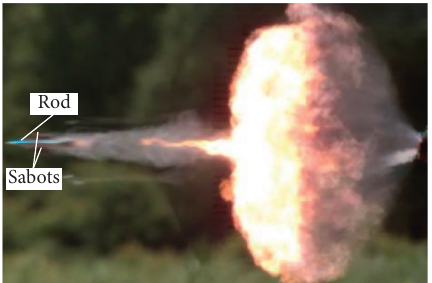
Figure 1: Launching phenomenon of a rifled barrel APFSDS.